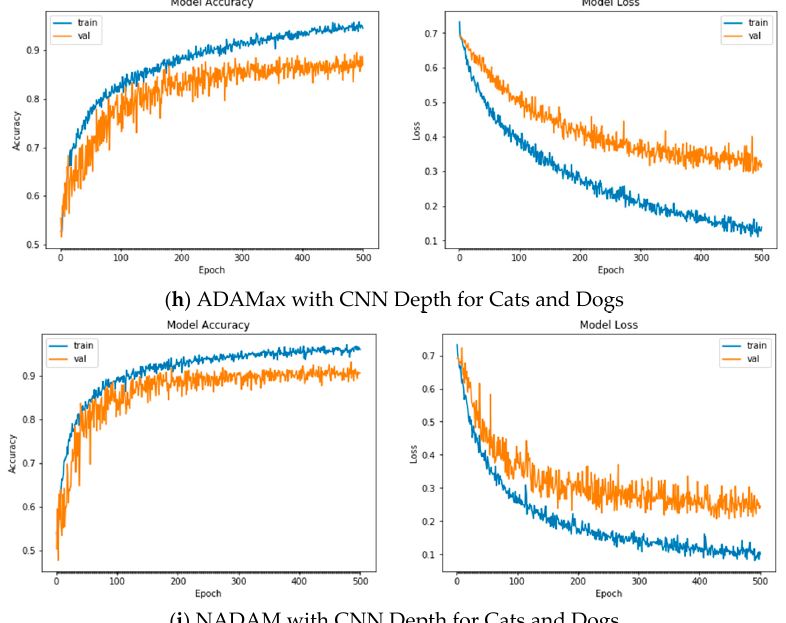
Figure A1. Plots of Train and Validation Test accuracies and losses of the CNN model with varying depth for Cats and Dogs: ( a ) Vanilla SGD; ( b ) SGD momentum; ( c ) SGD Nesterov momentum; ( d ) ADAGrad; ( e ) RSMProp; ( f ) ADAM; ( g ) ADADelta; ( h ) ADAMax; ( i ) NADAM.